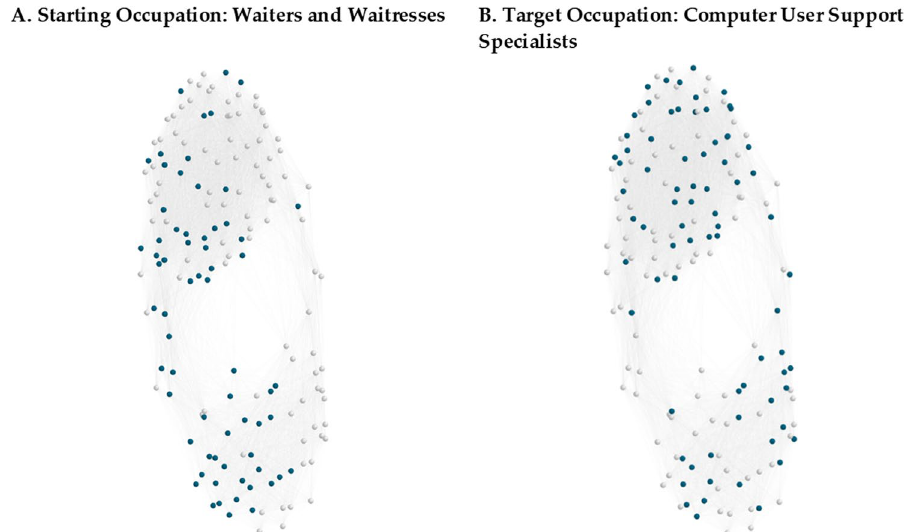
Fig. 2 Occupation locations of ( A ) N S and ( B ) N T within the full skills network G . Here the starting occupation S is “Waiters and Waitresses” and the target occupation T is “Computer User Support Specialist”. Skills present in N S and N T are highlighted while those absent are greyed out. Though negative link values are used to calculate occupational proximity P S → T , they are excluded from these visualizations, which were rendered in Pajek using the Kamada-Kawaii